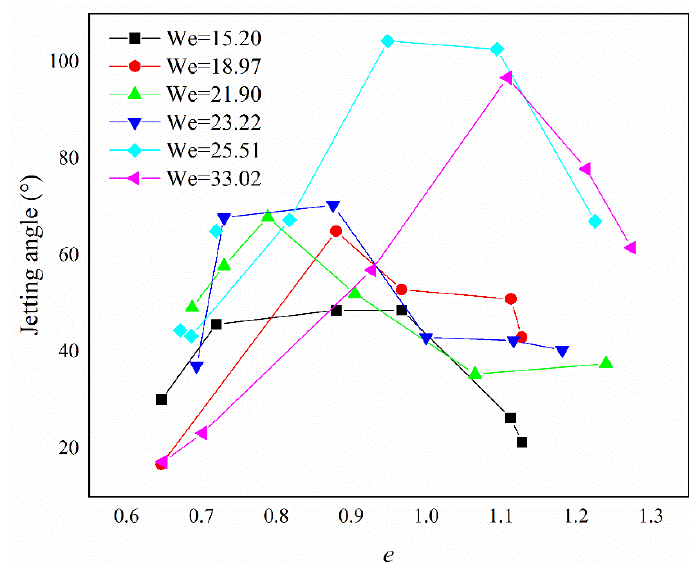
Figure 4. The jetting angle under different conditions.